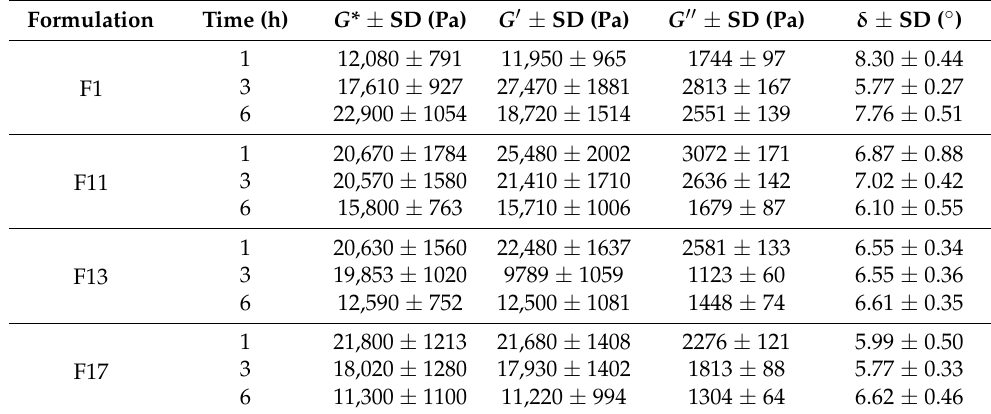
Table 3. The values of complex modulus G *, elastic modulus G ′, and viscous modulus G ″ a phase angle  for matrix tablets F1, F11, F13, and F17.